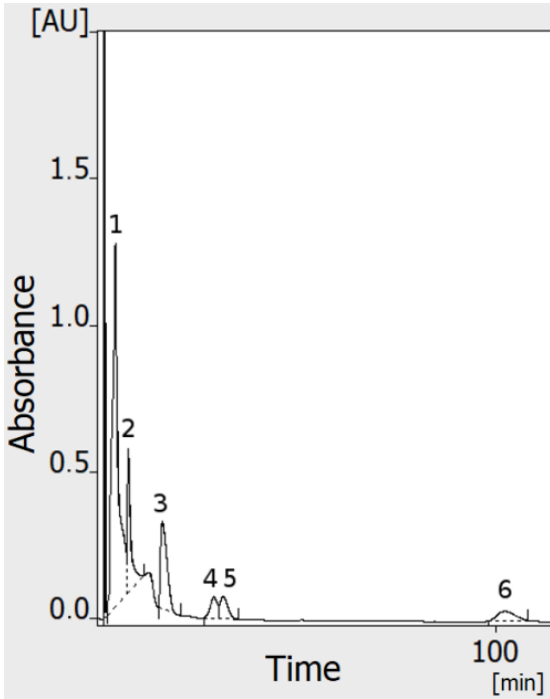
Figure 5. Chromatogram OPLC with offline sample application and online detection: 1 µL of the mixture was applied to the five separation channels using Linomat 5 aerosol sampler. Separation system used: HPTLC RP-18 W chromatographic plates; water/methanol (3/2 v/v ) with addition of 80 mM ammonium formate pH 3.0 as the mobile phase; total mobile phase flow 0.25 mL/min; voltage 0 kV; temperature 25 °C, cushion pressure 100 bar; and mobile phase backpressure 96 bar. Dye mixture: 1 — ponceau red; 2 — sunset yellow; 3 — allura red; 4 — brilliant blue; 5 — azorubine; and 6 — patent blue; each dye concentration was 0.07% w/v .